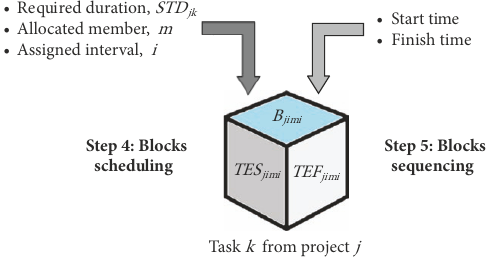
Figure 5. The results of optimal blocks scheduling from Step